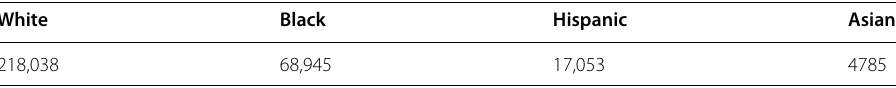
Table 4 Number of trajectories considered for each group